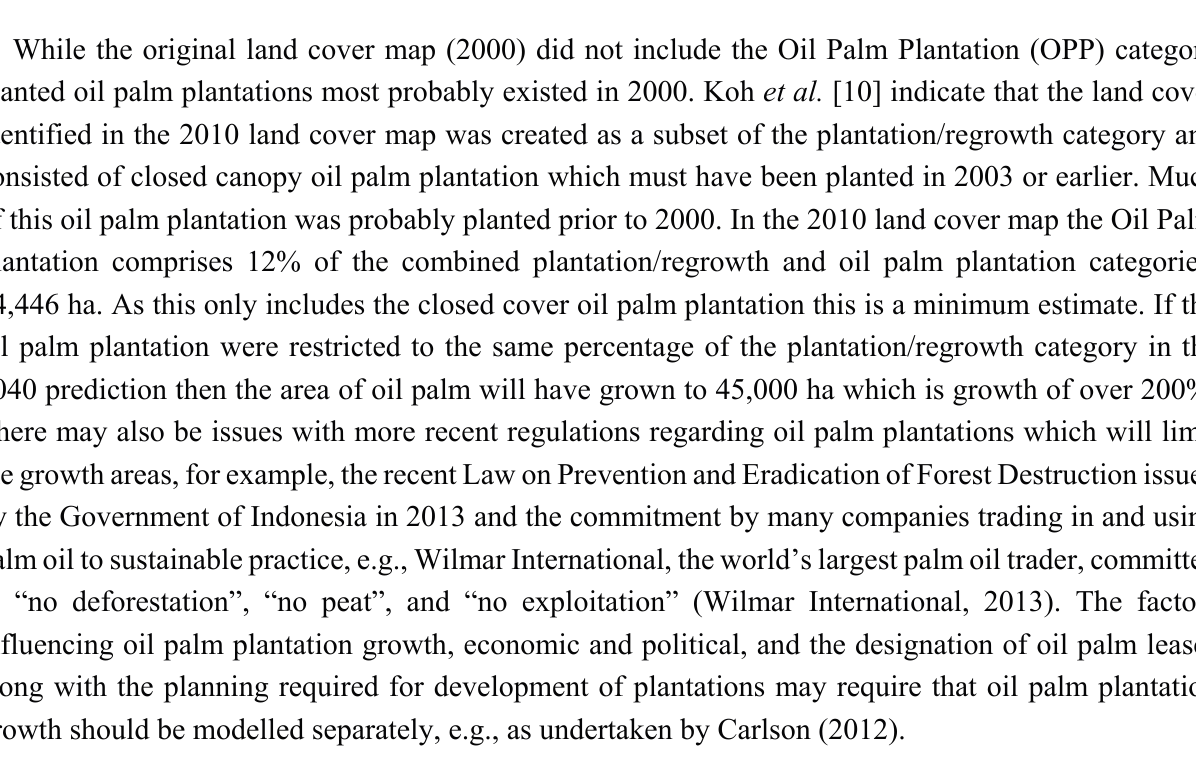
Figure 4. Deforestation 2000–2040 showing areas of deforestation for Peat Swamp and Lowland forest with peat soil area, Berbak National Park and timber